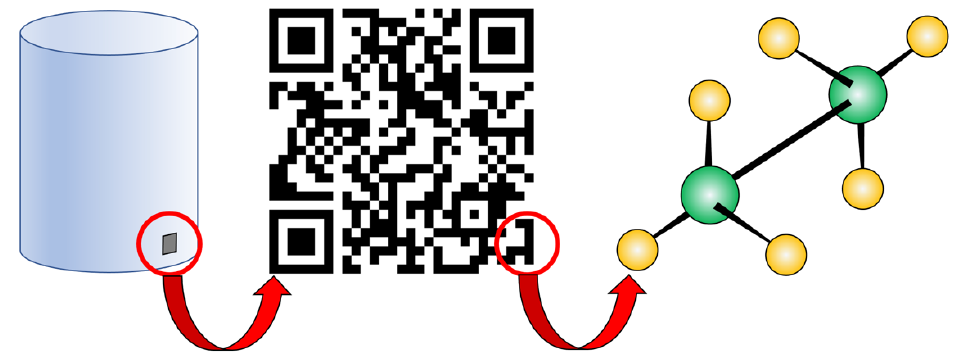
Figure 1. Example of a multi-level tagging feature that is composed of an ouverte QR code and of a chemical fingerprint (the static QR code redirects to A. Sola’s ORCID page, https://orcid.org/0000-0002-8649-9388 (accessed on 22 December 2021); the image is only for illustrative purposes, and the chemical structure shows a mock compound).